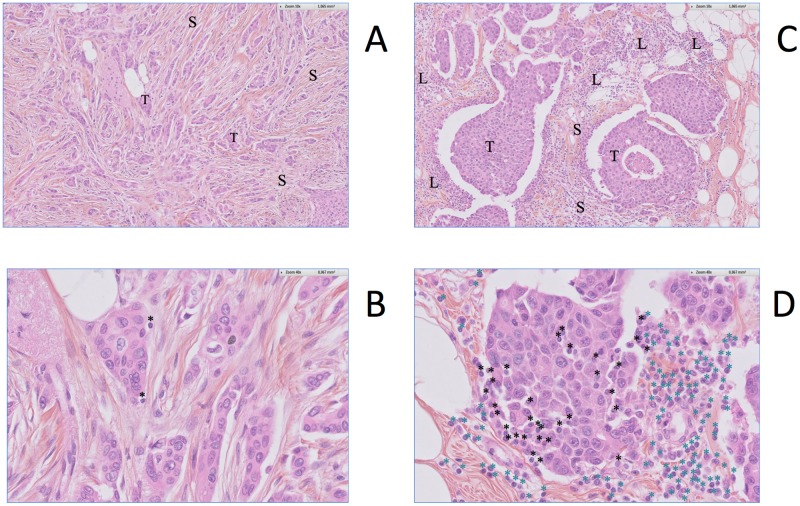
Lymphocytic infiltration in breast tumors.A and B: Tumor specimen with weak lymphocytic infiltration (A: zoom x10 B: zoom x 40). Abbreviations: S = stroma, T = tumor, L = lymphocytes. Intratumoral TILs are indicated by a black star. C and D: Tumor specimen with prominent lymphocytic infiltration. (C: zoom x10 D: zoom x 40). Abbreviations: S = stroma, T = tumor, L = lymphocytes. Intratumoral TILs are indicated by a black star; stromal TILs are indicated by a blue star.